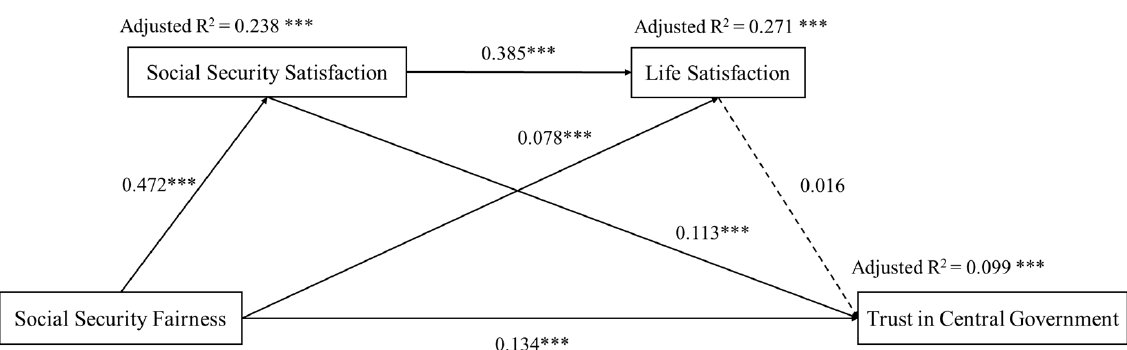
Figure 2. The serial mediator model of social security fairness, social security satisfaction, life satis- faction, and trust in central government after adding the control variables ( n = 7403). Standardized regression coefficients are marked next to the arrows. Adjusted R 2 is marked above the explained variable. *** p < 0.001.